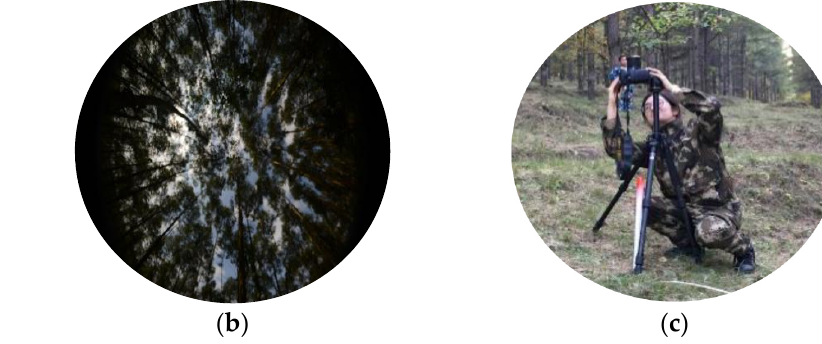
Figure 2. ( a ) The location of the fisheye camera photographs in one plot; ( b ) a sample of a fisheye camera photo; ( c ) a scene from the field measurements.